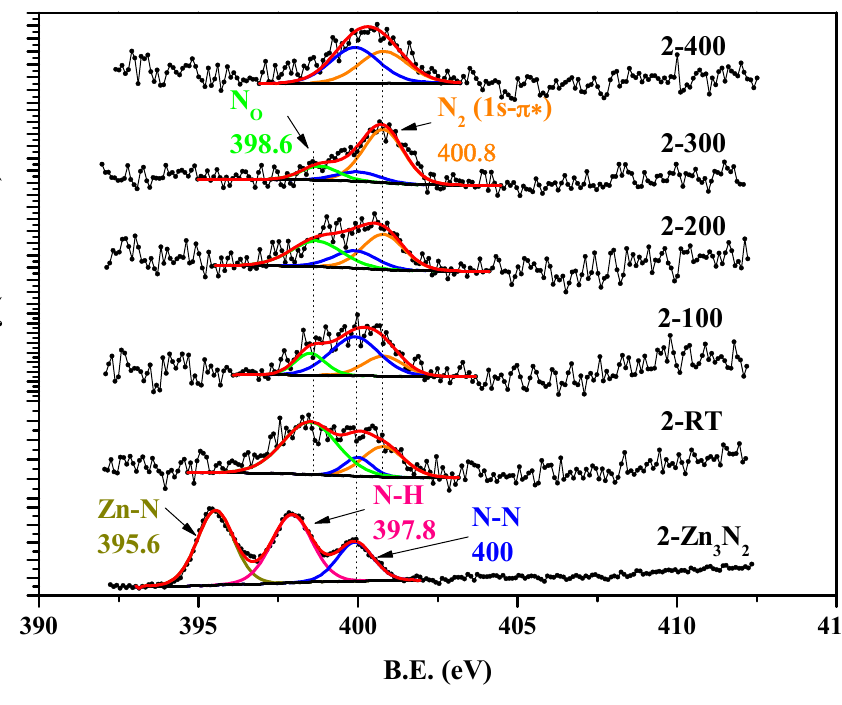
Figure 3. N 1s core-level X-ray photoelectron spectroscopy (XPS) spectra of as-grown 2-Zn 3 N 2 film and ZnO:N films.